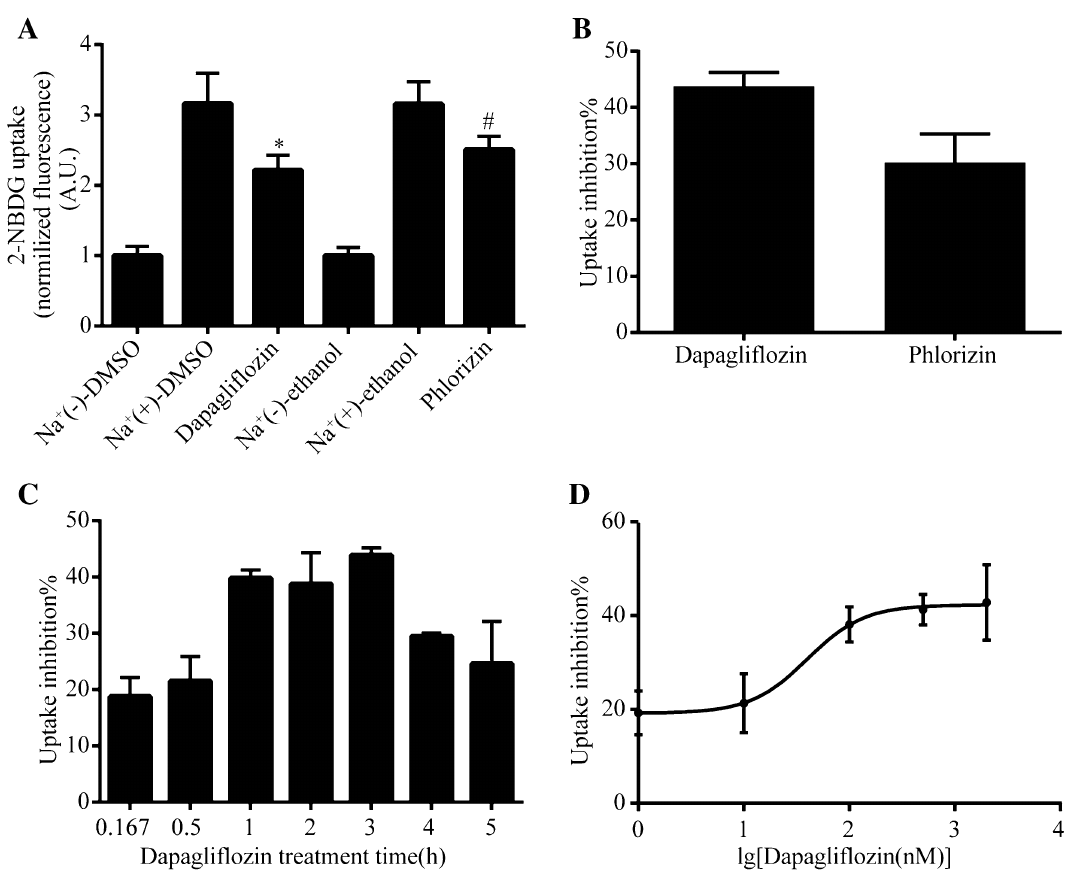
Fig. 5 SGLT2 inhibitors Dapagliflozin and Phlorizin blocks 2-NBDG uptake in HK-2 cells. a Inhibitory effect of Dapagliflozin (500 nM) or Phlorizin (100 l M) on 2-NBDG uptake in HK-2 cells. Values were normalized to the fluorescence intensity of 2-NBDG uptake dissolved in Na ? ( - ) buffer. Experiments were performed in triplicate and data are presented as mean ± S.E.M. of three independent